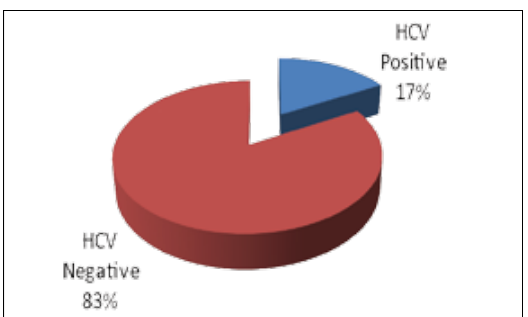
Fig 2. Distribution of HCV infection status of thalassaemia patients